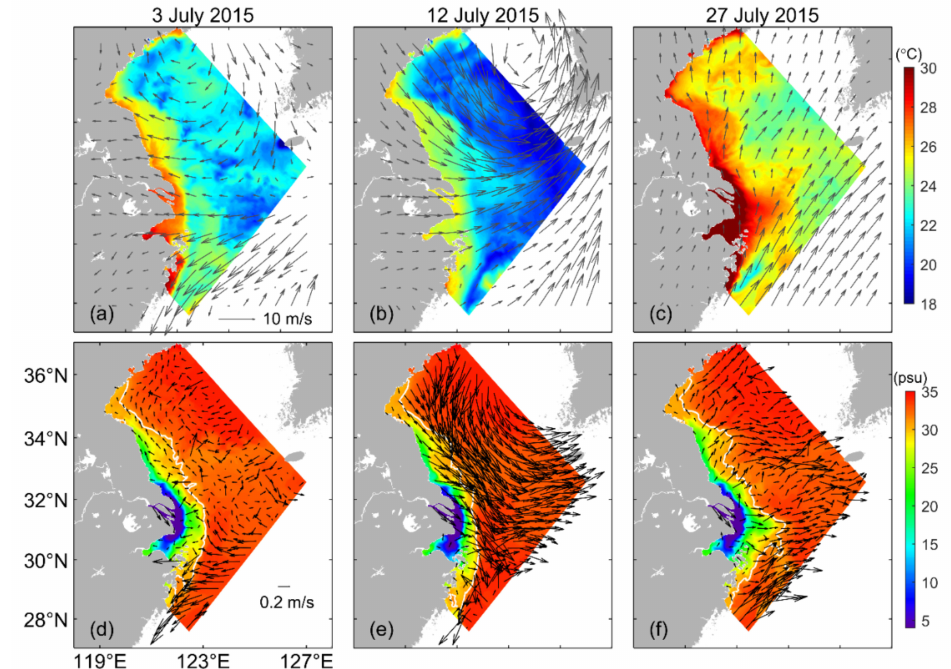
Figure 18. Distribution of daily mean wind vectors at 10 m (grey arrows in a – c ) derived from NCEP atmospheric reanalysis data, and simulated SST (image in a – c ), SSS (image in d – f ) and sea surface currents (black arrows in d – f ) produced by the inner model in CR, respectively, before (3 July), during (12 July) and after (27 July) the passage of Typhoon Chan-Hom. White contour lines in lower panels represent 31 psu